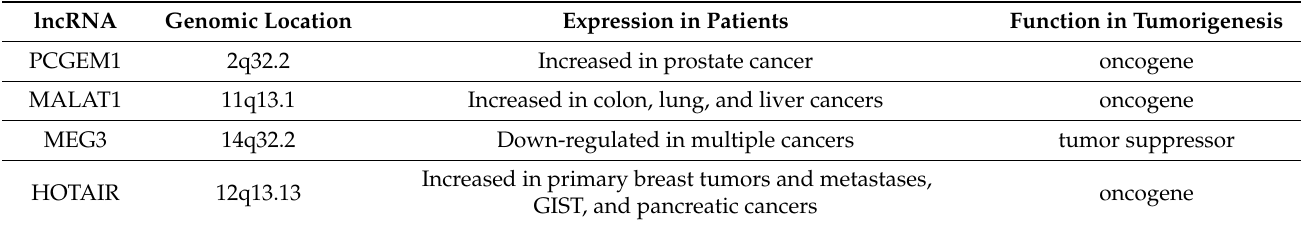
Table 1. Long noncoding RNAs involved in